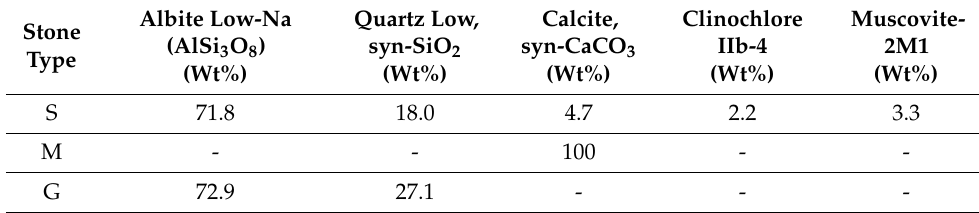
Table 1. Mineral components of the stones and their proportions by X-ray diffraction.